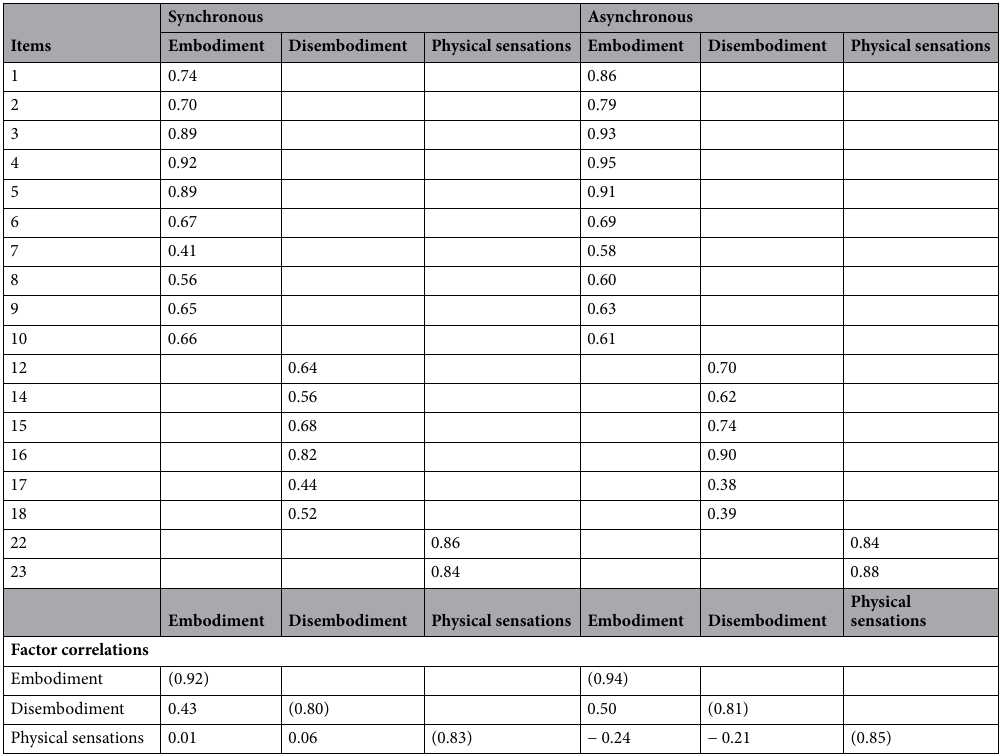
Table 2. Matrix of standardised loadings of the CFA of the 18 selected items. On the component correlations diagonals, Cronbach’s alpha of the scale is reported in the parenthesis.